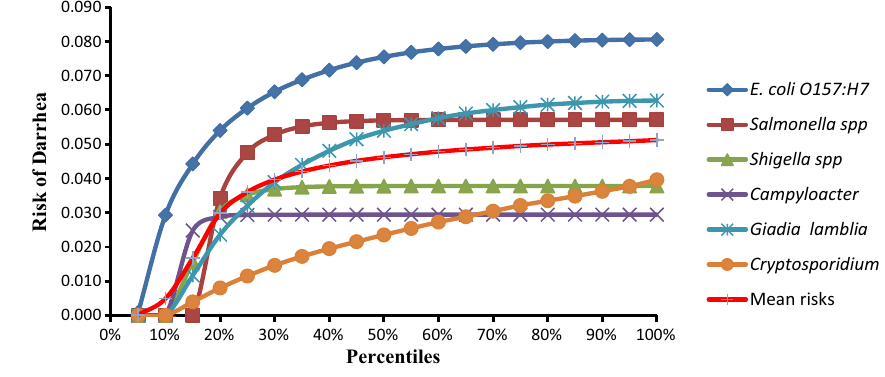
Fig. 2 Monte Carlo simulation